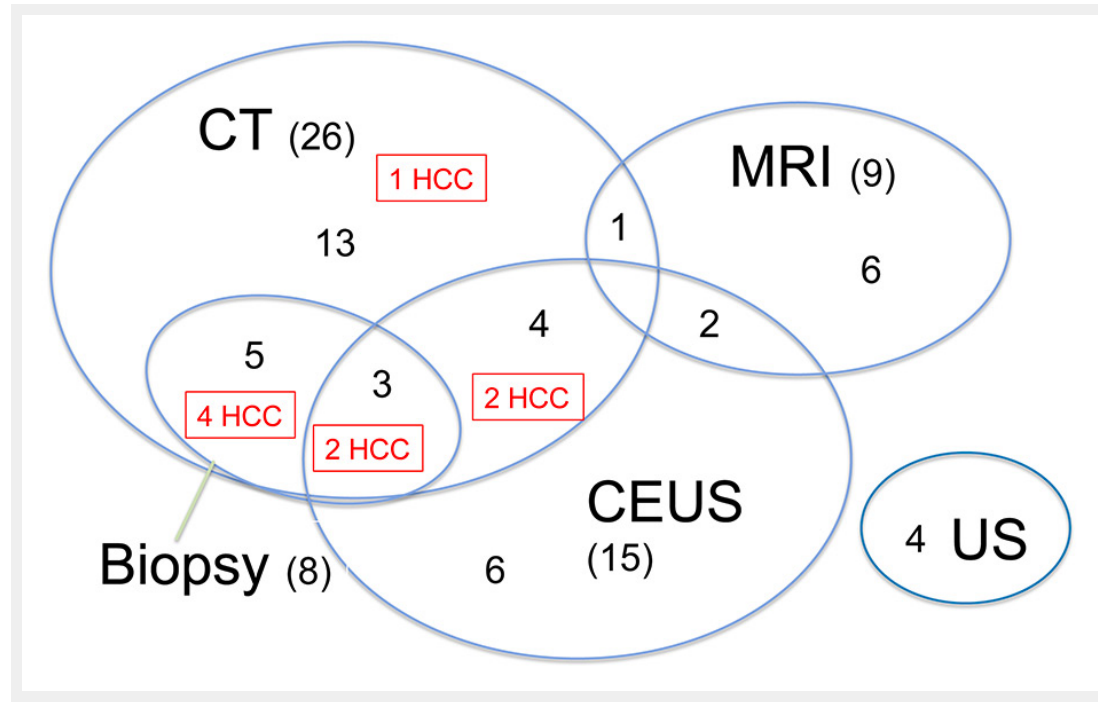
Figure 3 Number and combination of the examinations carried out in order to evaluate a suspicious lesion detected by surveillance ultrasound. Numbers in parenthesis show the total examination number for the different modalities. Regular numbers show the number of patients with any given combination of examinations. The red boxes highlight the examinations used in patients diagnosed with HCC. CT = computed tomography;; CEUS = contrast enhanced ultrasound; HCC = hepatocellular cancer; MRI = magnetic resonance